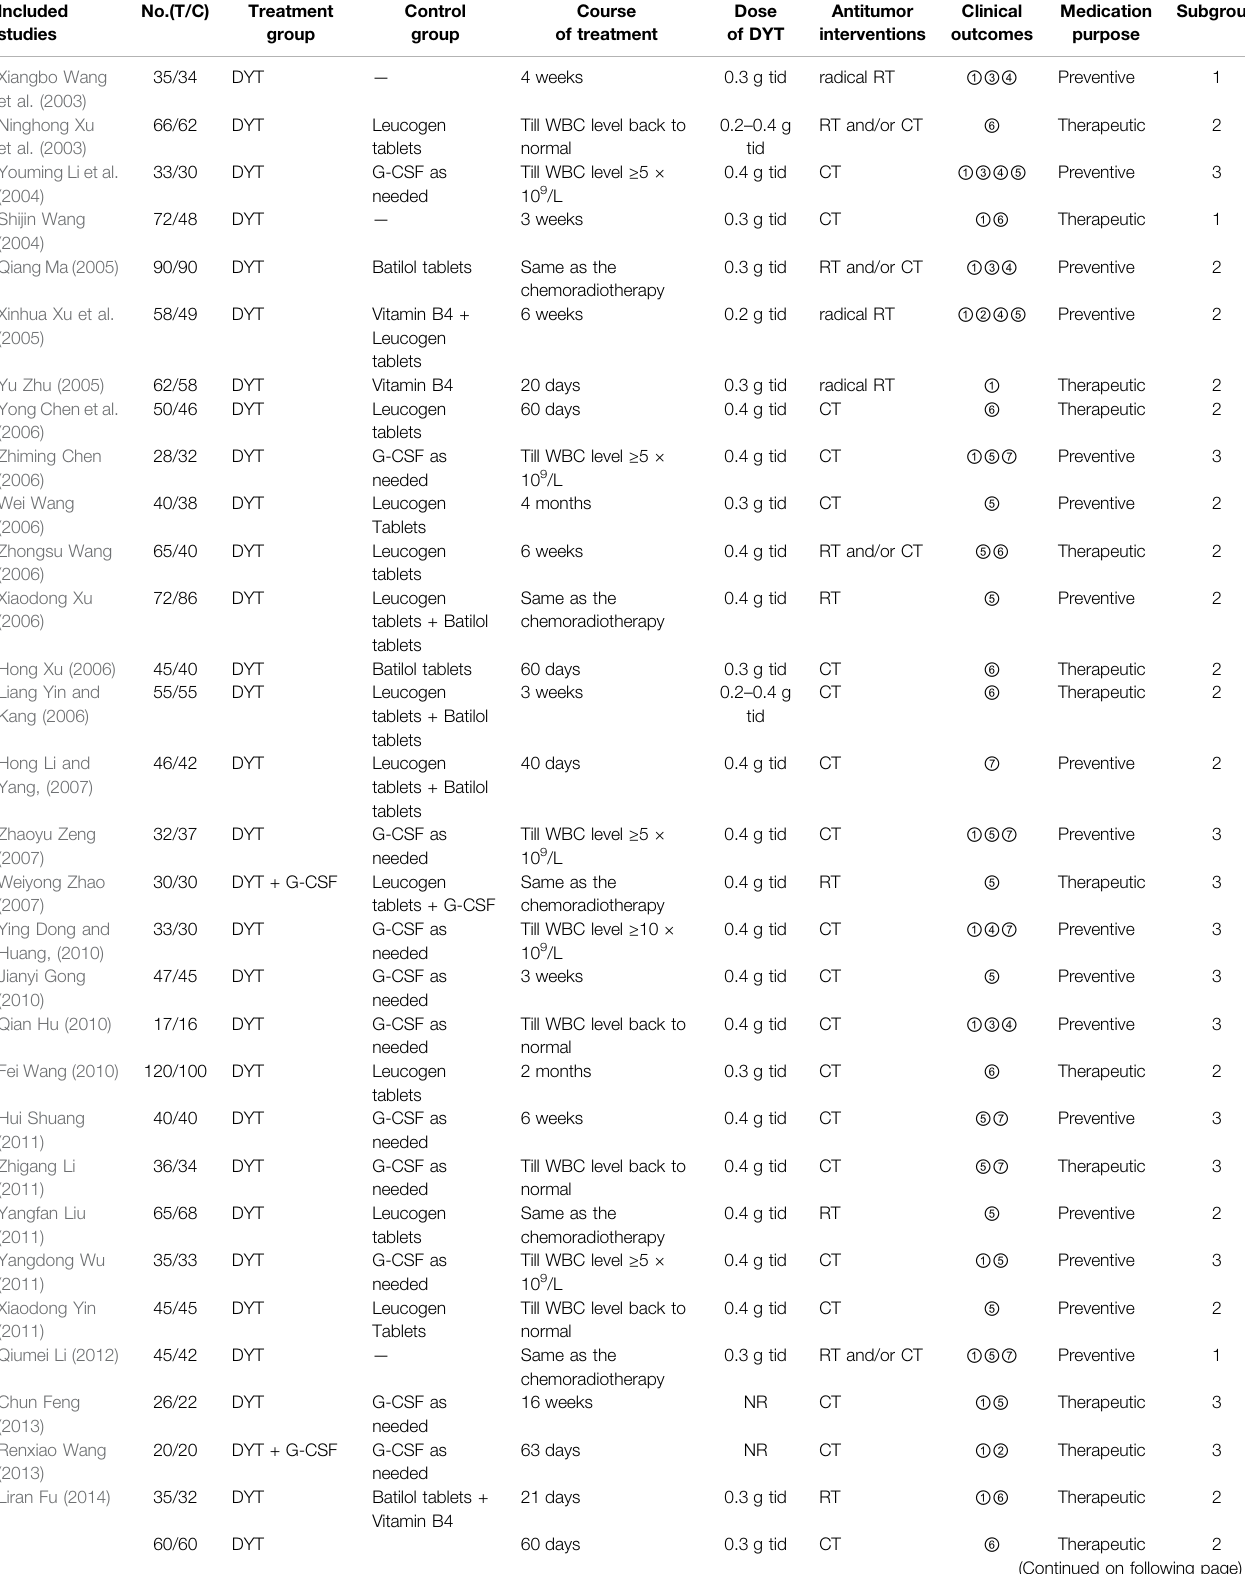
TABLE 1 | Information of included studies. Included